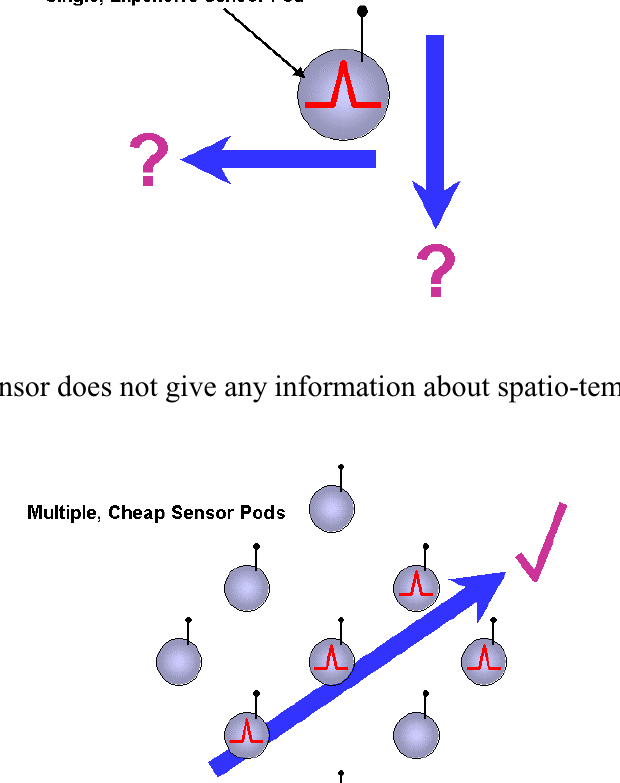
Figure 2. Multiple sensors provide lower resolution but more data and thus can yield sophisticated